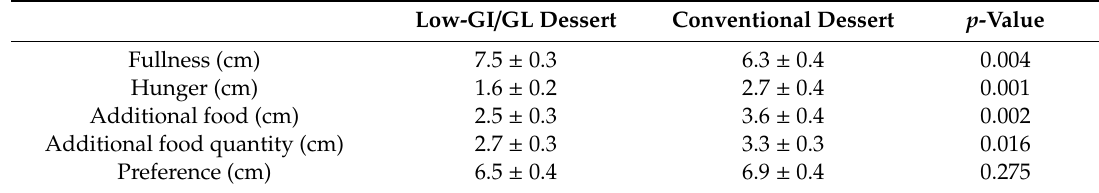
Figure 2. Incremental area under the curve (iAUC) for glucose ( a ) and insulin ( b ) (mean ± SEM) following consumption of low-GI / GL and conventional desserts. Statistical significance ( p < 0.05) between response to low-GI / GL dessert and control is indicated by *. Table 3. Ratings for fullness, hunger, additional food, additional food quantity, and total preference after consumption of the two